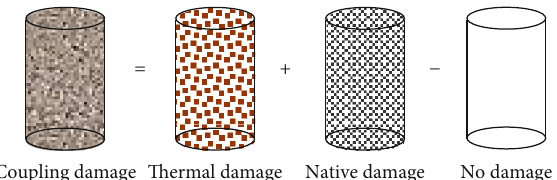
Figure 5: The calculation method of equivalent strain of rock